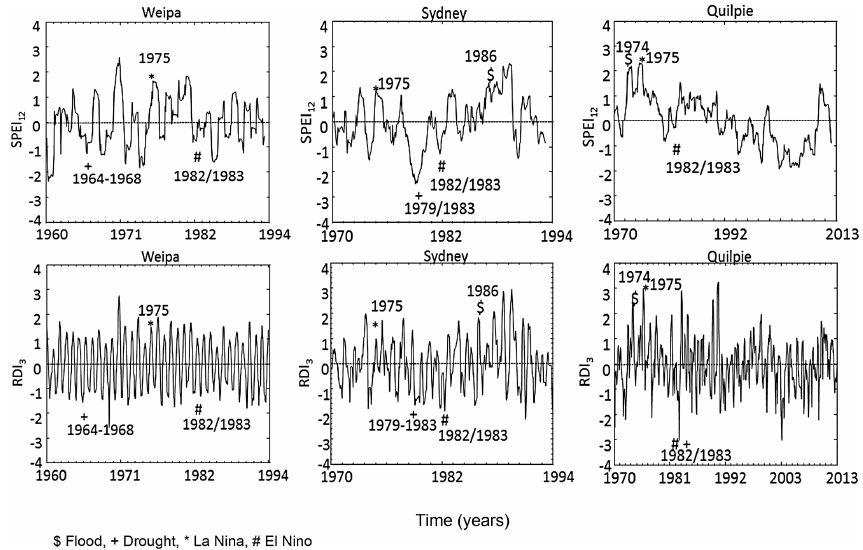
Figure 4. Calculated SPEI 12 (upper row panels) and RDI 3 (lower row panels) for Weipa, Sydney and Quilpie including major weather events. The same indices are depicted for all other selected locations in Appendix